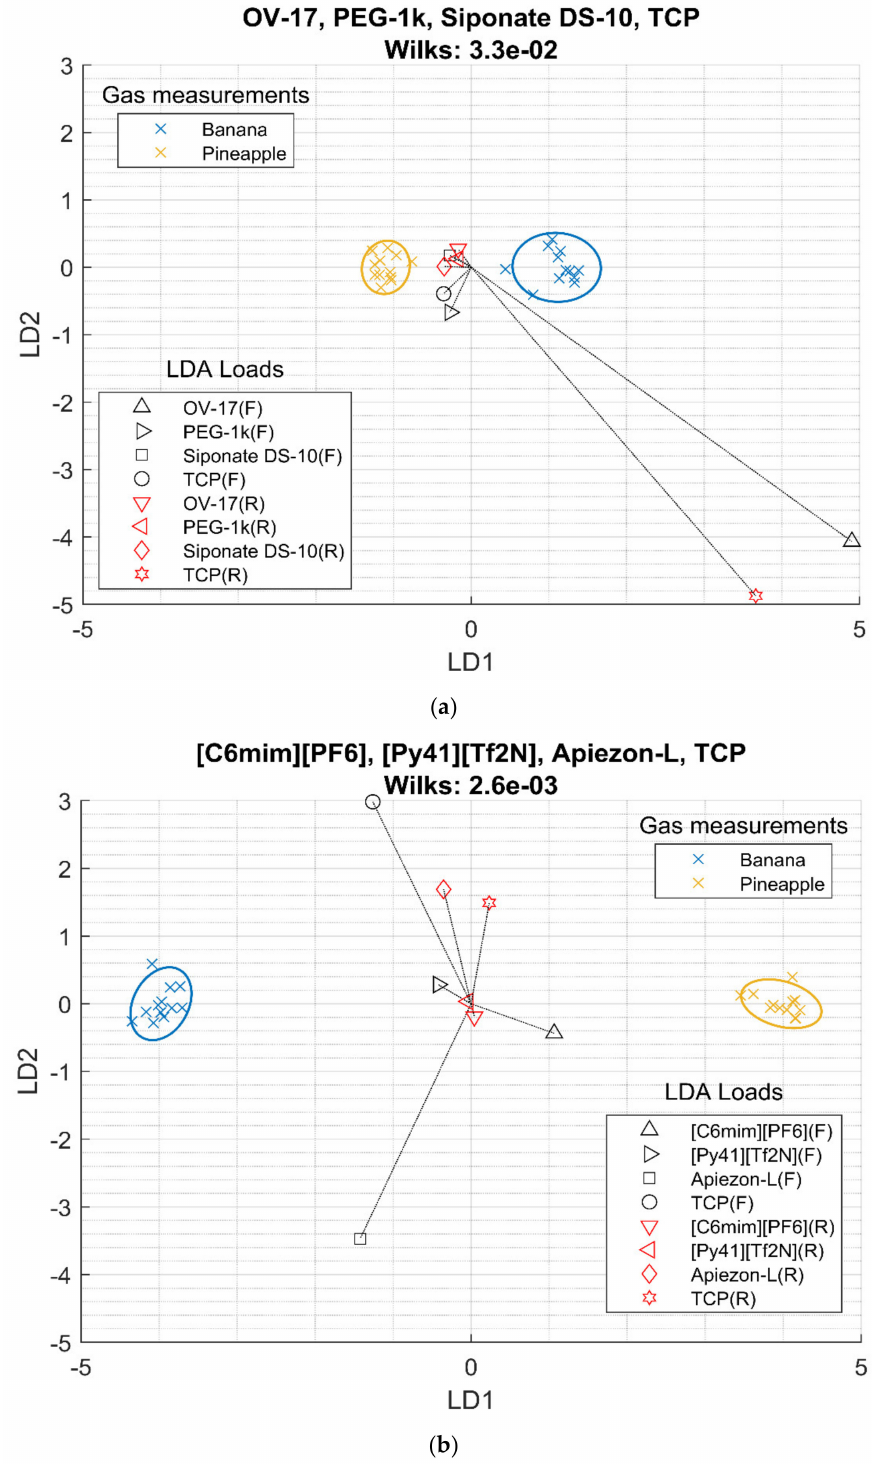
Figure 5. LDA bi-plot for the best sensor array using frequency (F) and resistance (R) data of the 2 scents measured. ( a ) Conventional films. ( b ) Best sensing film